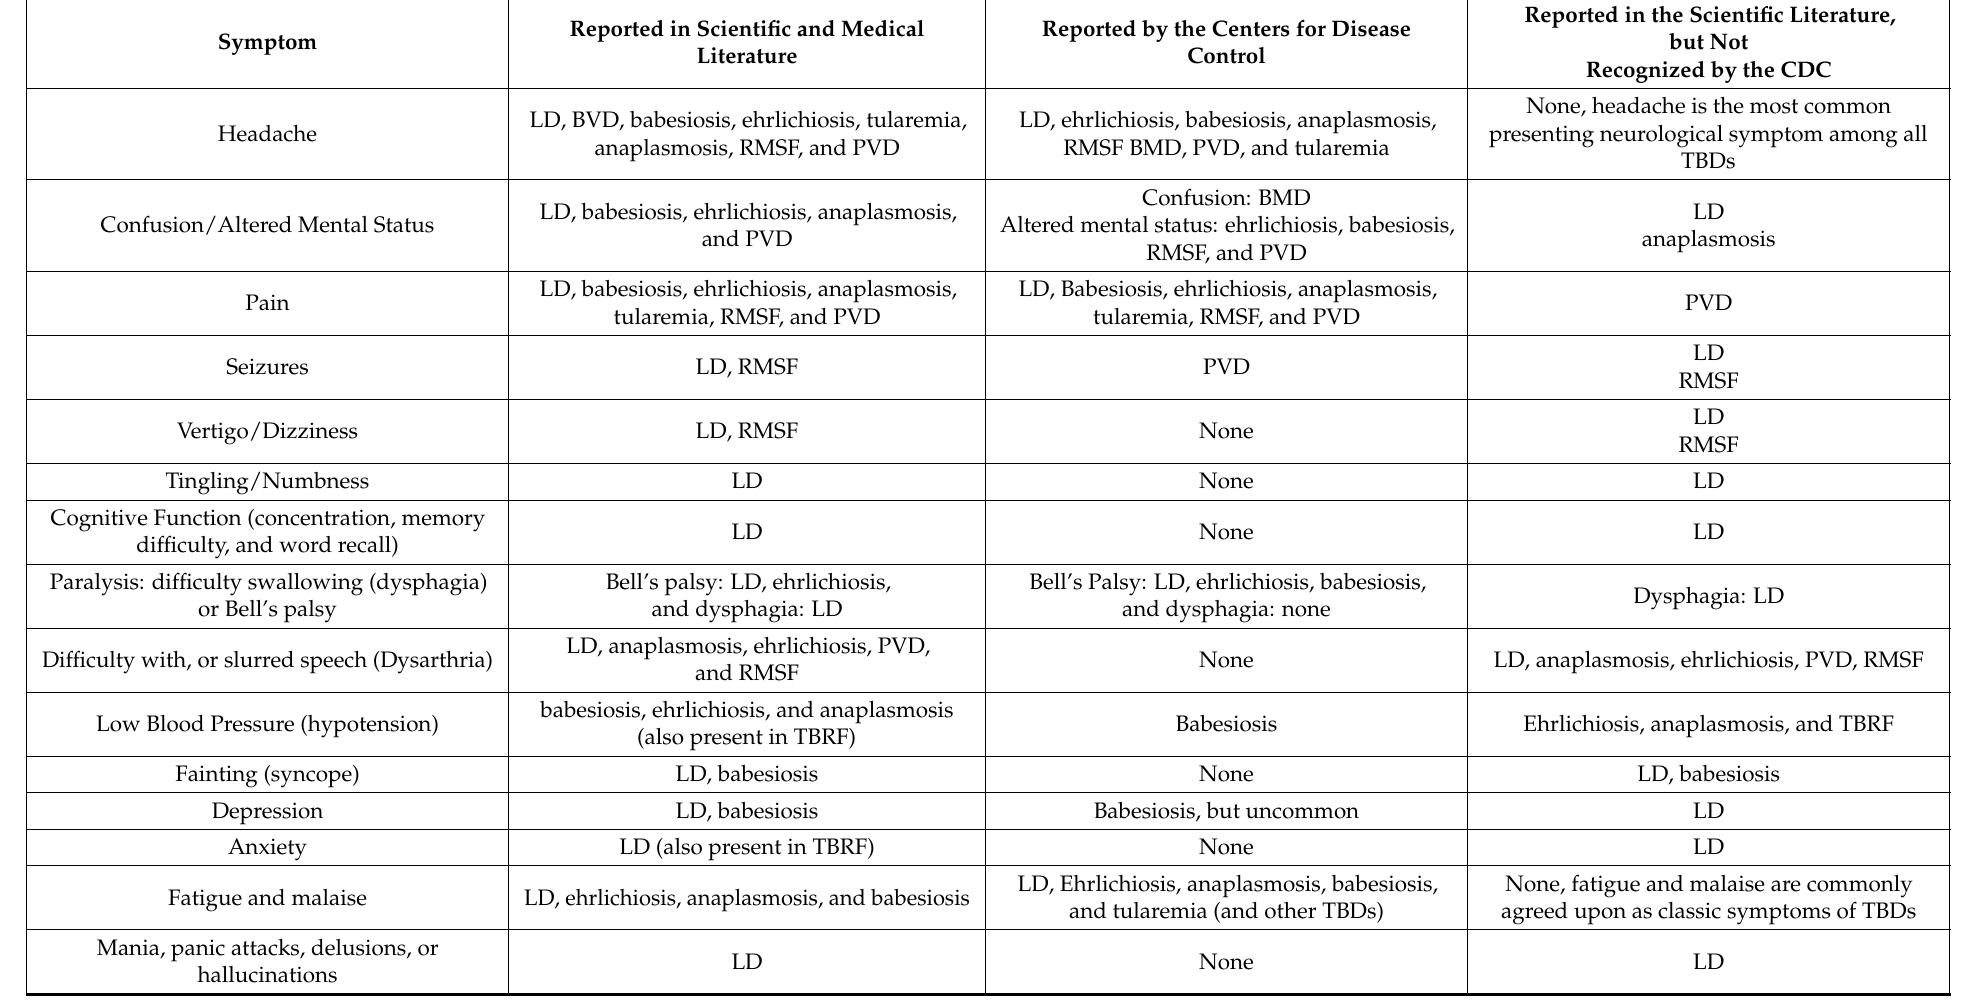
Table 17. Symptom comparison from medical literature and the public health reference manual for common